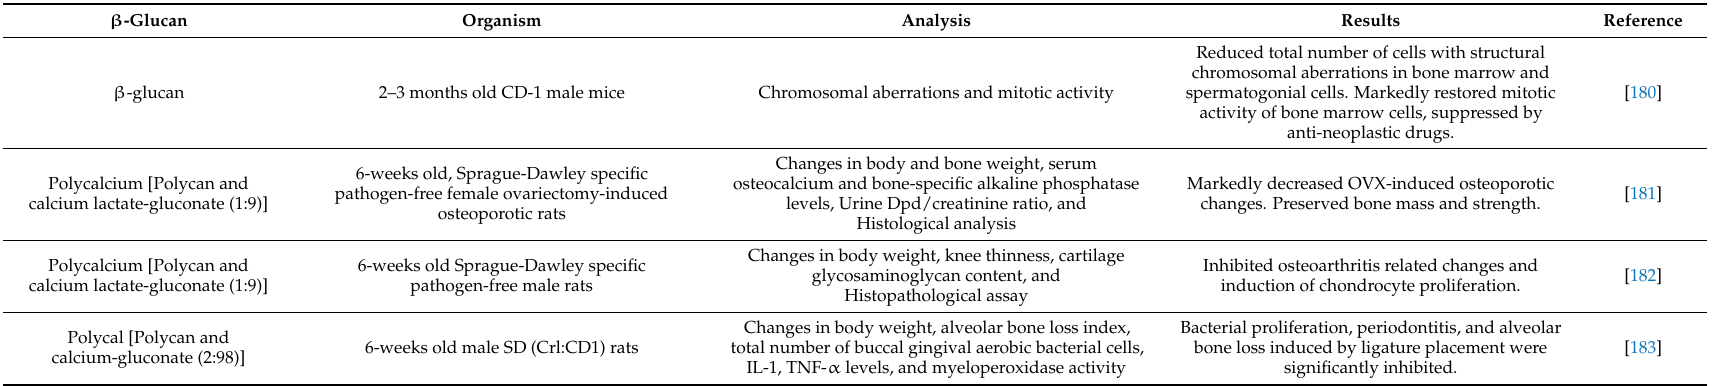
Table 9. Bone regeneration/bone injury healing effects of β -glucans—animal